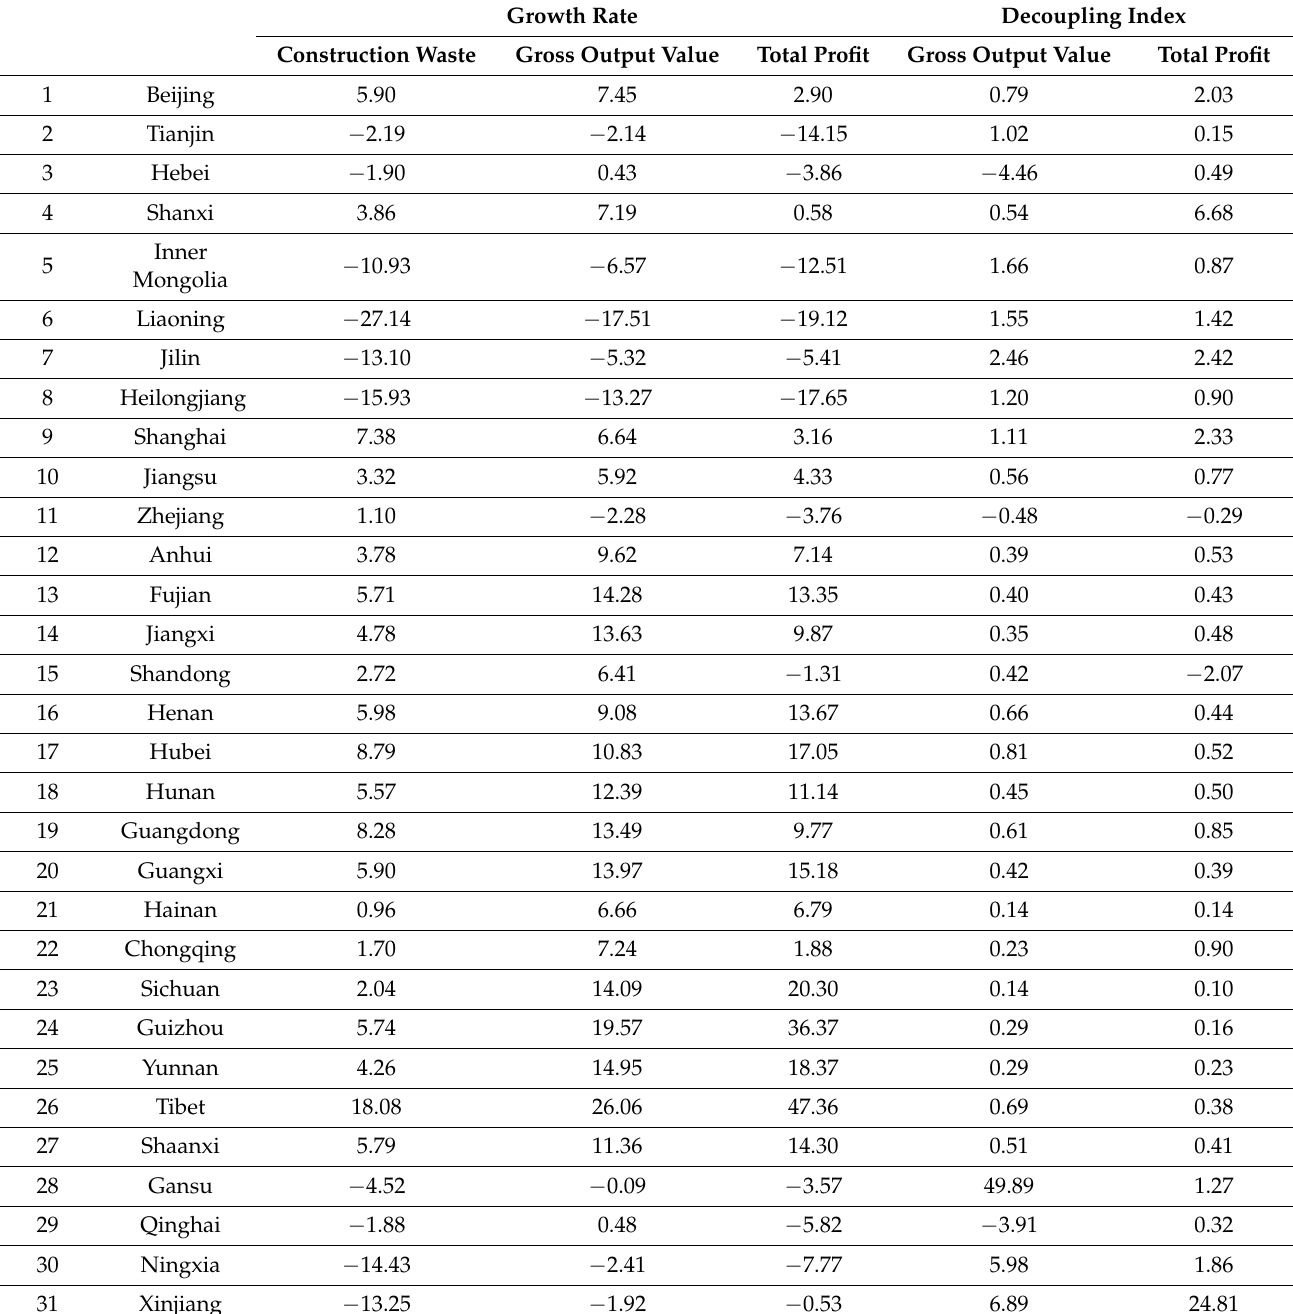
Table A2. Growth rate and decoupling index of construction waste and economy from 2014 to